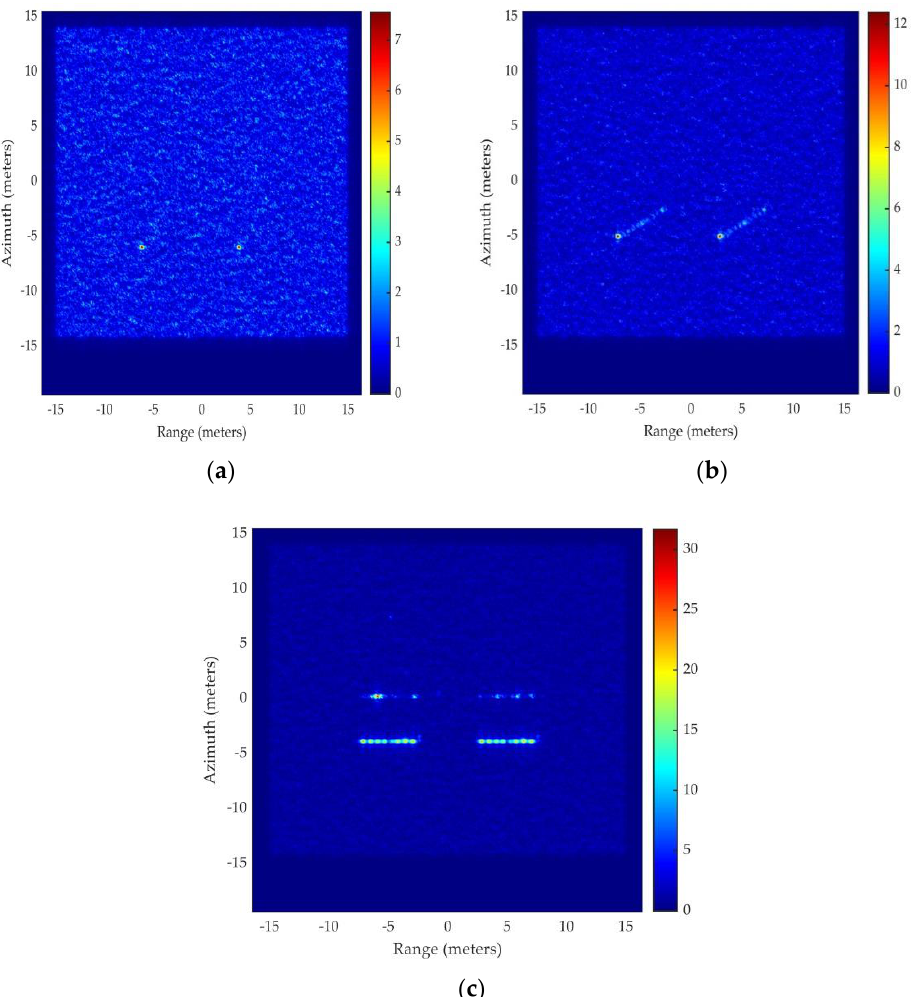
Figure 14. SAR images of two missile−like targets with different courses above sea surface: ( a ) rotation angle 30 ◦ ; ( b ) rotation angle 60 ◦ ; ( c ) rotation angle 90 ◦